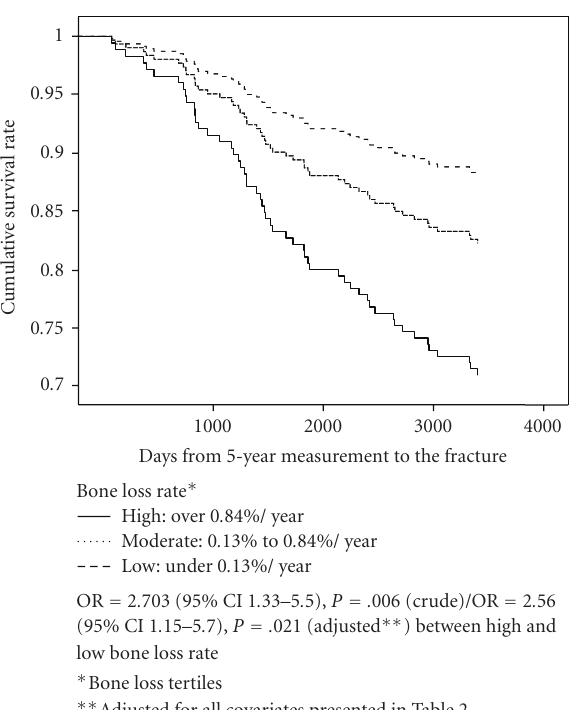
with self-reported mother’s fracture. Cox proportional hazards model ( n =